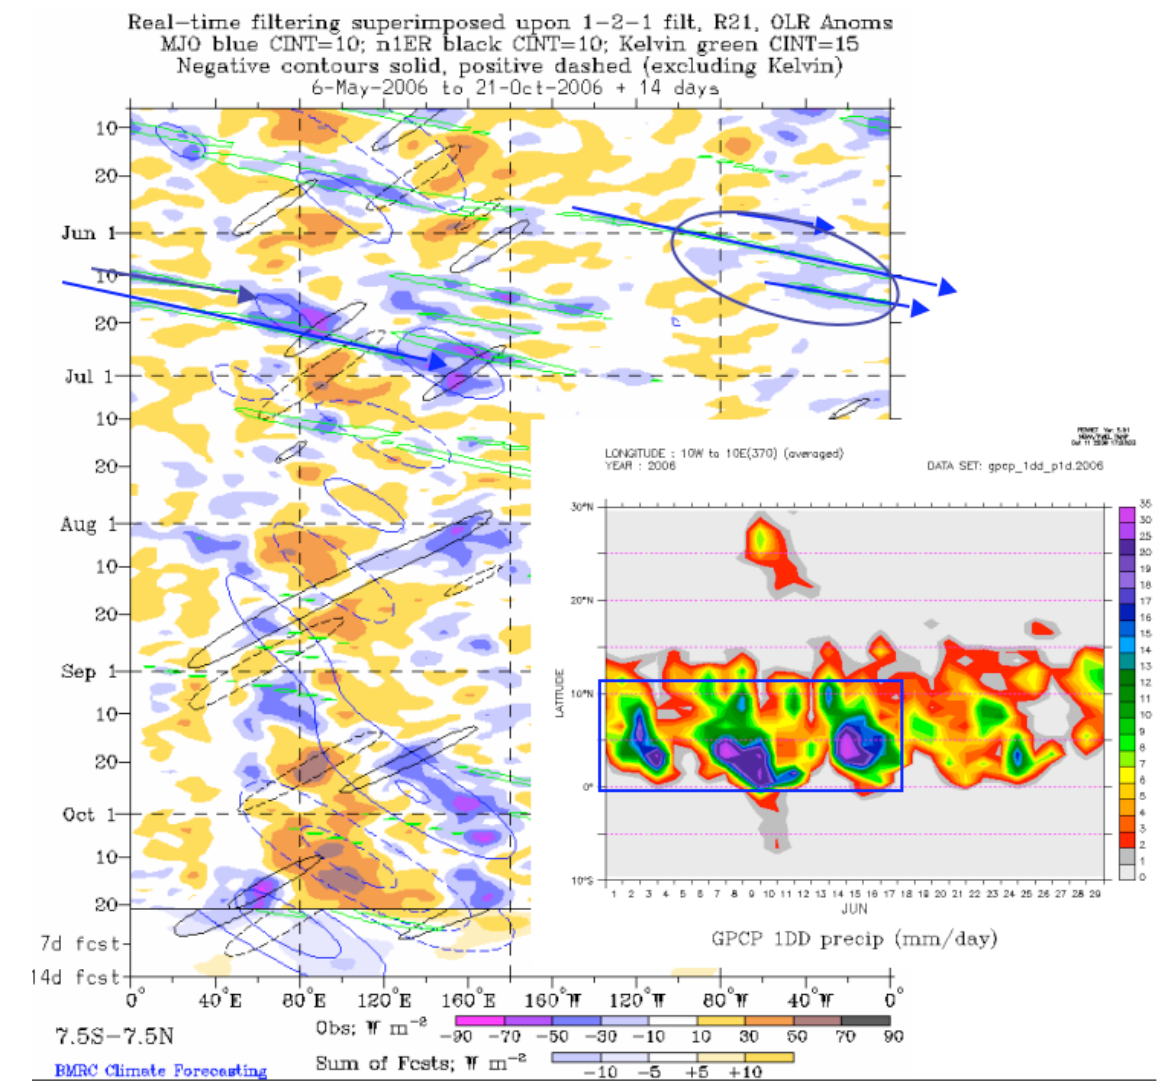
Figure 20. Time-longitude diagram of OLR anomalies based on 1979-2001 and averaged over longitudes 7.5°S-7.5°N (shaded), and real-time filtering of OLR (green ellipses for equatorial Kelvin wave, black ellipses for equatorial Rossby wave, blue ellipses for MJO signal) from May to October 2006 ( http://www.bom.gov.au/bmrc/clfor/cfstaff/matw/maproom/OLR_modes/index.htm; courtesy of M. Wheeler). Blue arrows delineate the Kelvin wave occurrences in June crossing Africa. The panel on the right depicts the time-latitude diagram of GPCP daily rainfall estimate averaged on 10°W-10°E in June 2006. The blue big ellipse on the time-longitude diagram highlights the train of three Kelvin waves crossing Africa in June and their rainfall impact is highlighted by the blue rectangle on the time-latitude diagram.